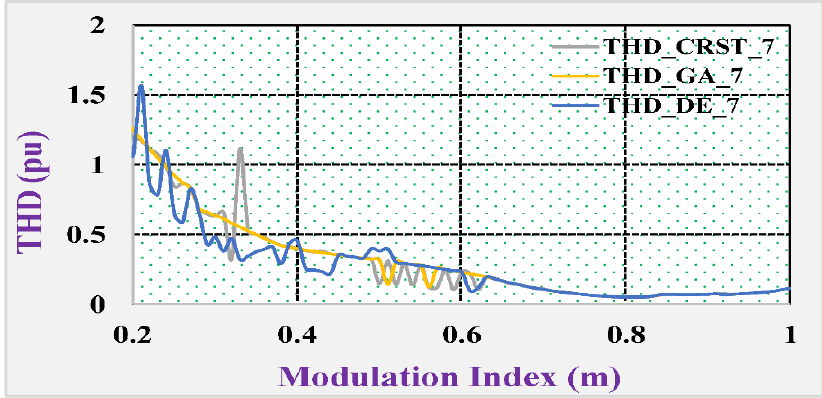
Figure 21. Variation of the THD using the DE, GA, and CryStAl at different modulation index for seven-level.